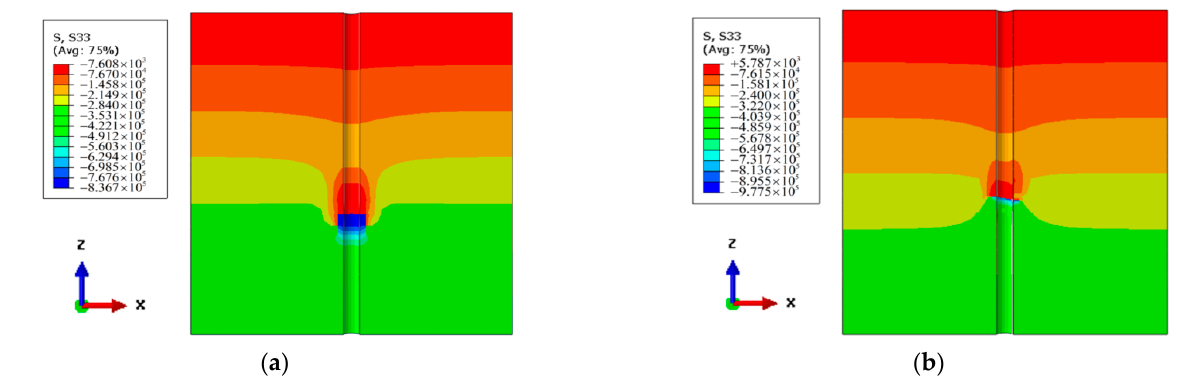
Figure 7. Stress nephogram of soil around the piles. ( a ) Monopile; ( b ) Helical pile. The variation of vertical stress in the soil on the side wall of the pile in the depth direction is shown in Figure 8. The change in stress of the monopile is relatively sharp, first increasing gradually with depth, then exhibiting a sharp increase or even mutation at about 25 m. The soil in the pile reached a maximum of 25 m. The maximum values were 0.54 MPa and 2.75 MPa, for the helical pile and the monopile, respectively, representing a five-fold difference. Locations of stress concentrations outside the pile are different. The stress of the soil surrounding the pile reaches a maximum at the lower part of the pile bottom, whereas the stress concentration of the helical pile is located at the blade. The maximum pressure of the monopile was 2.02 MPa, and that of the helical pile was 0.81 MPa. The blade greatly alleviates damage to the soil, thereby reducing the stress concen- tration.